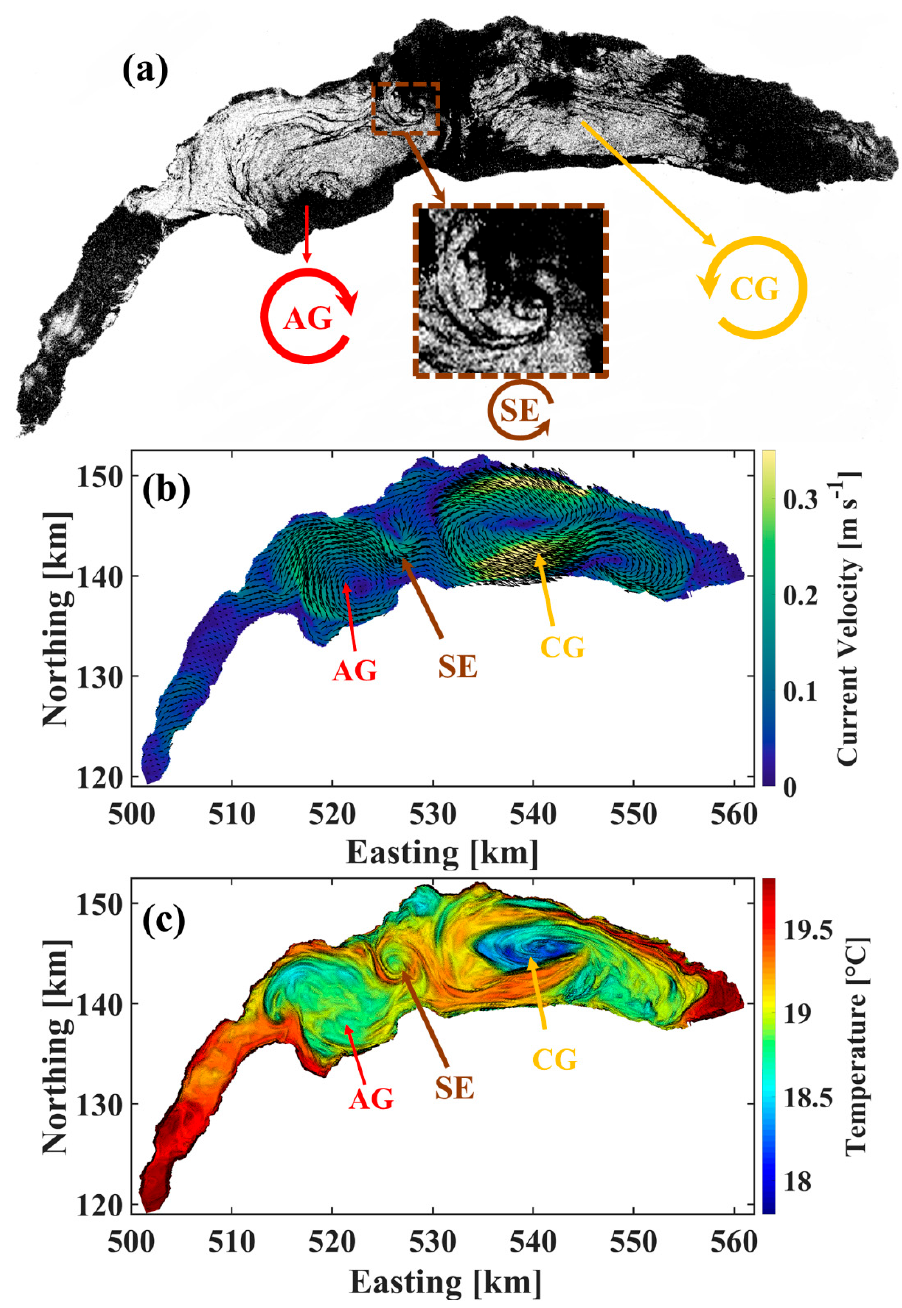
Figure 4. ( a ) Sentinel-1A SAR-C image of Lake Geneva acquired on 20 September 2019 at 17:31 UTC. AG: anticyclonic gyre; CG: cyclonic gyre; SE: submesoscale eddy. ( b ) Simulated current velocity at 0.3-m depth (arrows: direction; color: velocity; colorbar legend: velocity range). ( c ) Simulated temperature (0.3-m depth; colorbar legend: temperature range) from a high-resolution, 3D numerical simulation for 20 September 2019 at 18:00 UTC. Easting and northing coordinates follow the Swiss CH1903 system.